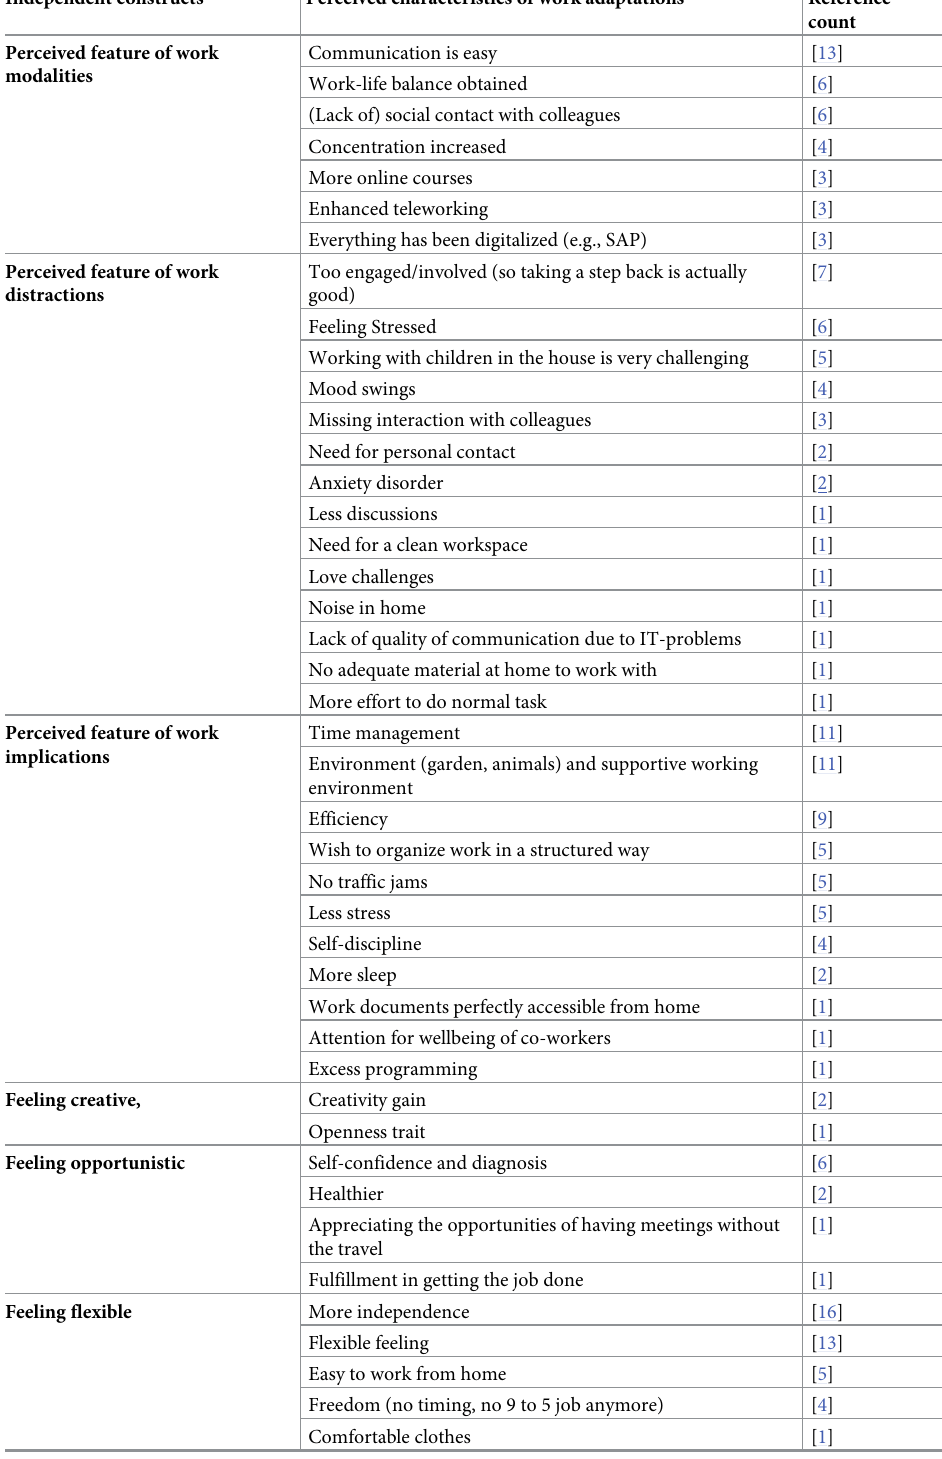
Table 6. Word counts for characteristics of work